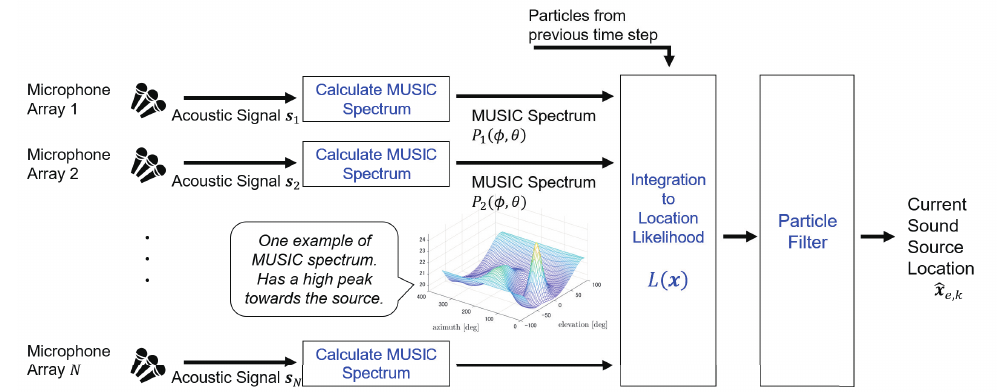
Figure 1. Procedure of proposed method (for one time